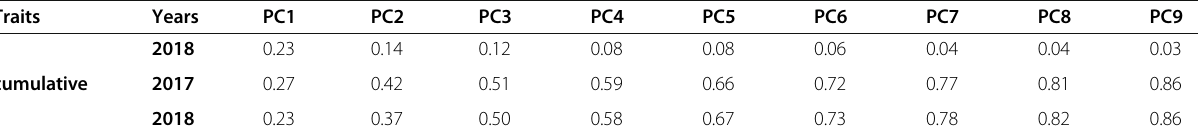
Table 2 Eigenvectors and eigen analysis of the correlation matrix for the nine principal components traits associated with stem hardness performance in G. hirsutum accessions (Continued)